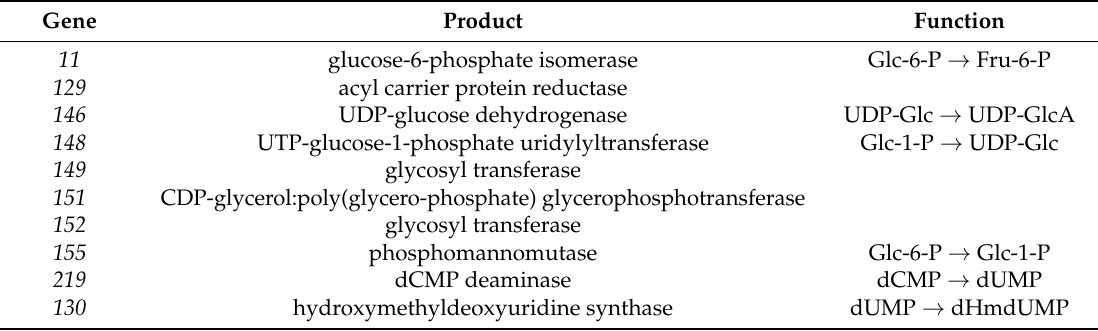
Table 2. Summary of the genes thought to be involved in the modification of the 4,5-dihydroxypentyl group attached to the 5-position of uracil (DHPU) residues in SP-15